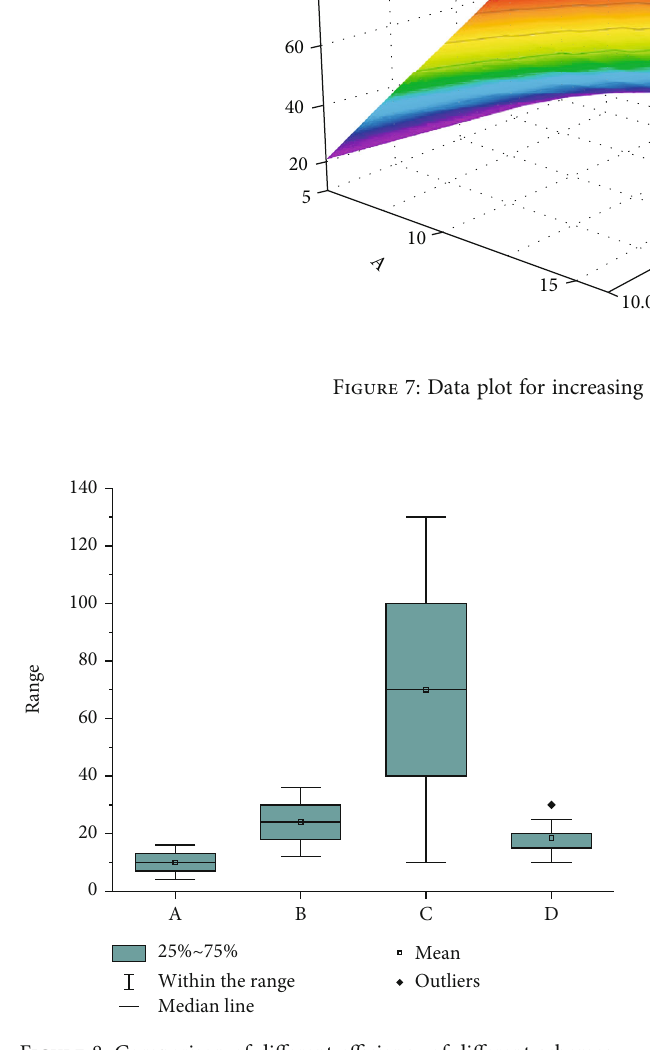
Figure 8: Comparison of di ff erent e ffi ciency of di ff erent